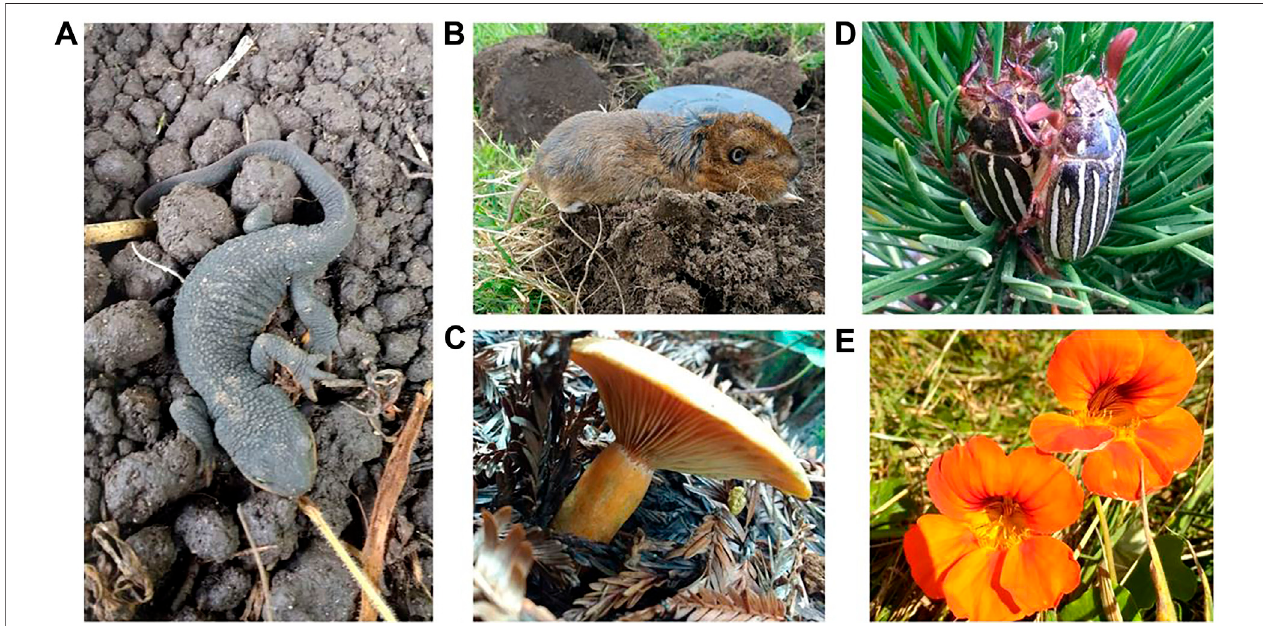
FIGURE 1 | Representative observations from the Tiny North Coast Places project on iNaturalist. (A) : rough-skinned newt ( Taricha granulosa ); (B) : Botta ’ s pocket gopher( Thomomysbottae ); (C) :saffronmilkcap( Lactariusdeliciosus ); (D) :ten-linedJunebeetle( Polyphylladecemlineata ); (E) :Nasturtium( Tropaeolum majus ).Images taken by E. F. van